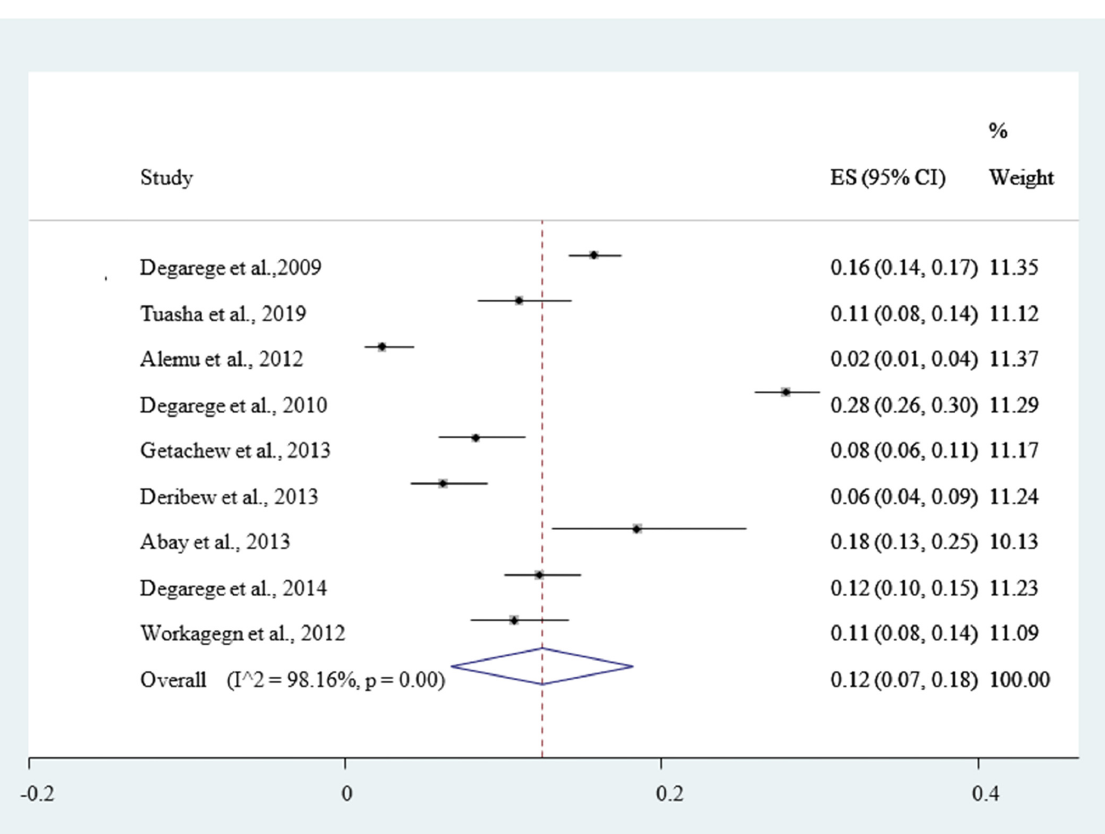
Int. J. Environ. Res. Public Health 2021 , 18 , 862 Figure 4. Forest plot of 9 studies on magnitude of Plasmodium falciparum infection among outpatients in Ethiopia, 2020.